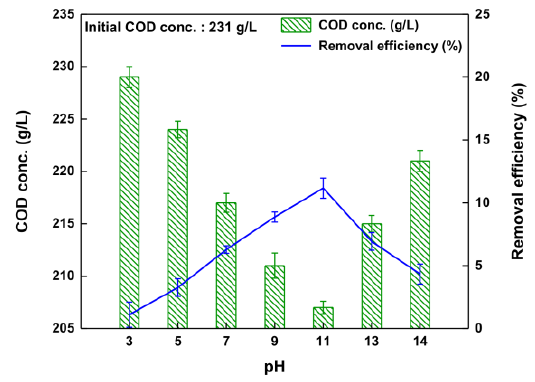
Figure 5. Removal efficiency of COD with various pH values during O 3 oxidation.